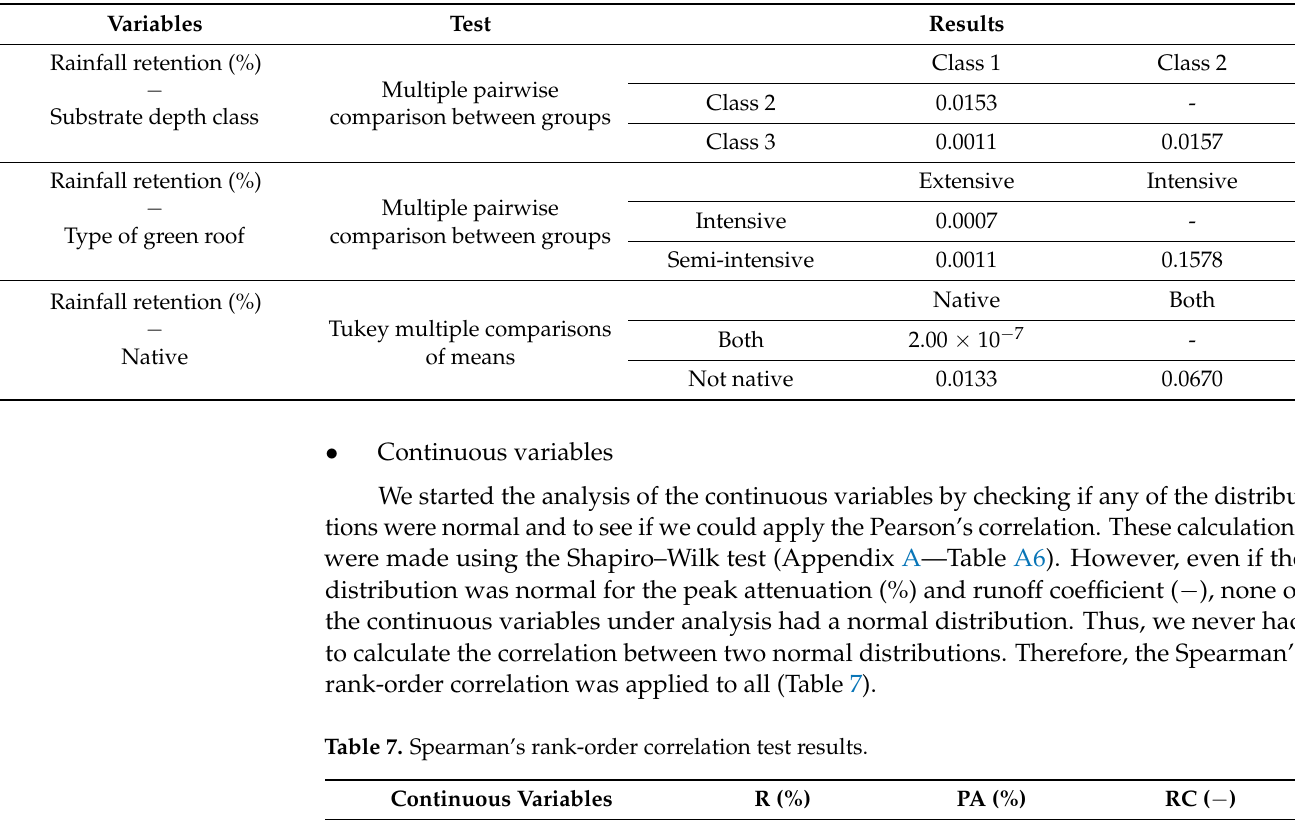
Table 6. p -values for the multiple pairwise comparison between groups test applied to the results of Kruskal–Wallis test and p -values for the Tukey multiple comparisons of means test applied to the results of ANOVA test.